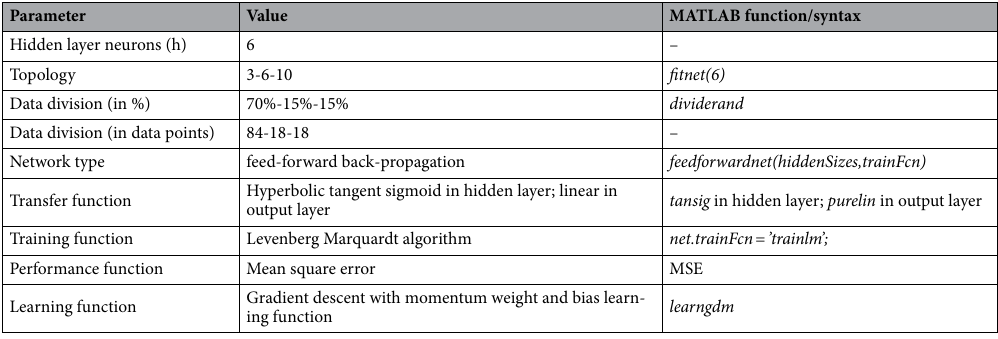
Table 7. ANN Settings used for